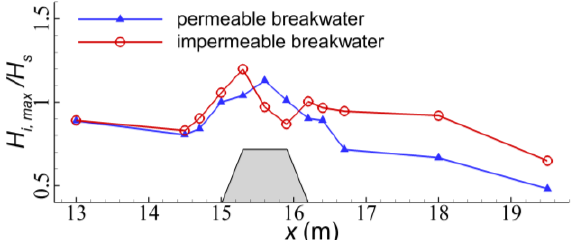
Figure 10. Spatial distribution of the maximum water elevations along the computational domain.